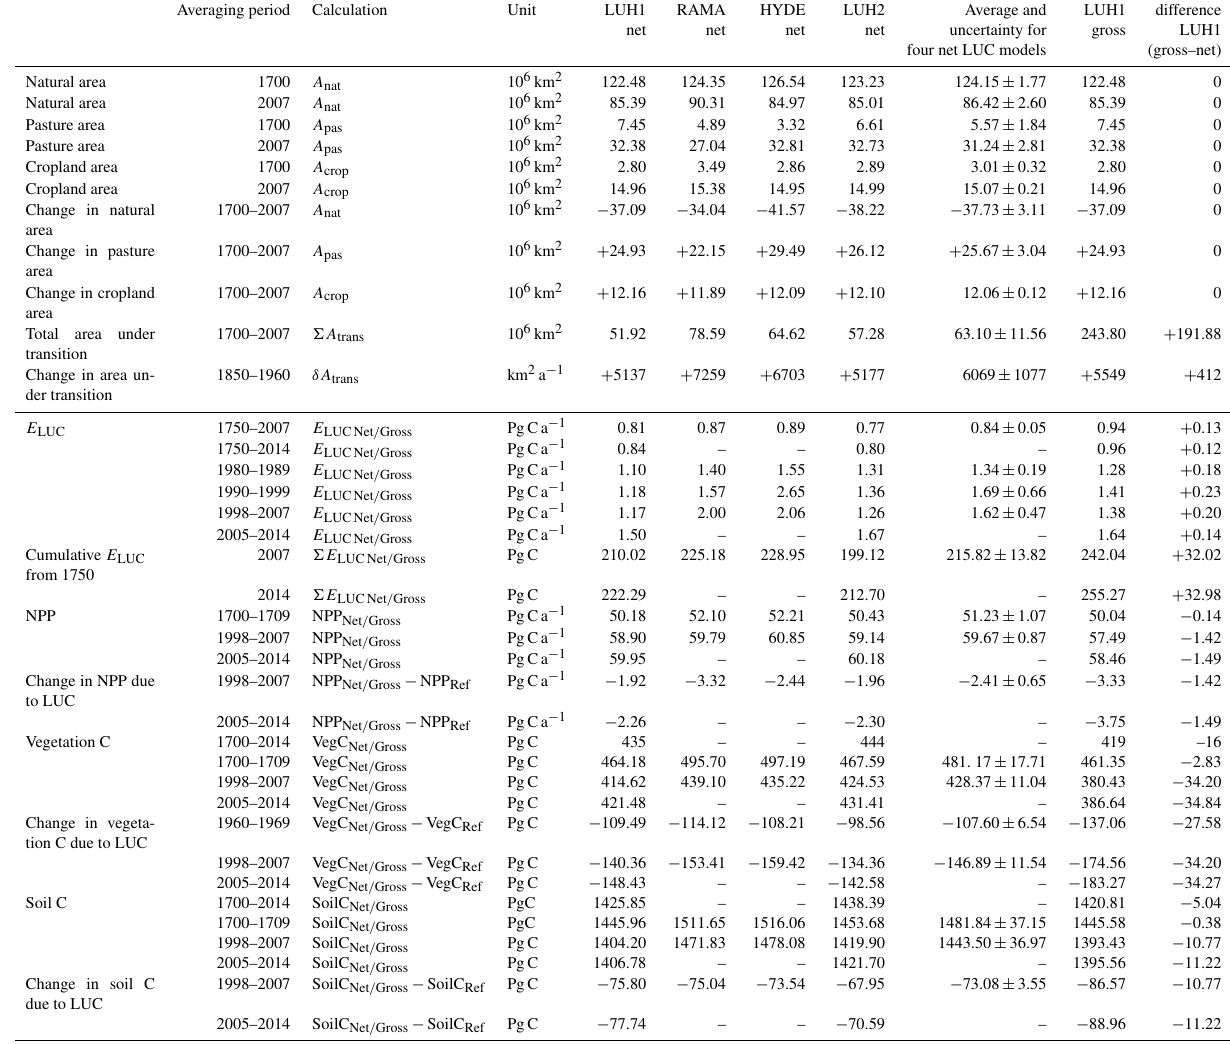
Table 3. Changes in C stocks and fluxes in four global reconstructions of net and gross LUC changes. Land-use change flux ( E LUC ) and cumulative land-use flux E LUC ; net primary productivity (NPP); C stocks in vegetation and soils. Values are always given as 10-year averages (except LUC areas and cumulative